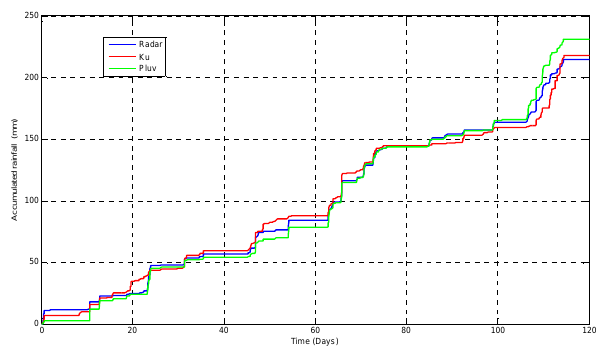
Fig. 10. Accumulated rainfall determined using the radar data (blue curve), rain gauge (green curve) and Ku-band attenuation measurements (red curve), over a 4 month period.